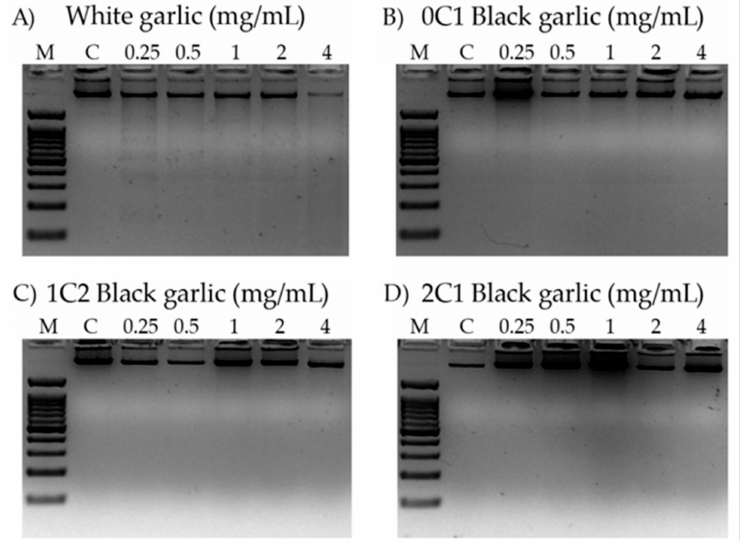
Figure 4. Internucleosomal DNA fragmentation in HL-60 cells treated for 5 h with di ff erent concentrations of black and white garlic. DNA fragmentation was detected following electrophoresis in agarose gels and staining with ethidium bromide. M: indicates DNA size marker; C: indicates control (lane 1); 0.25 mg / mL (lane 2); 0.50 mg / mL (lane 3); 1 mg / mL (lane 4); 2 mg / mL (lane 5), and 4 mg / mL (lane 6) of garlic sample. ( A ) White garlic, ( B ) 0C1: black garlic with 13 days aging, ( C ) 1C2: black garlic with 32 days aging, and ( D ) 2C1: black garlic with 45 days